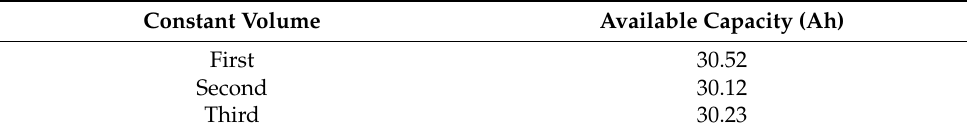
Table 4. Static capacity test results.